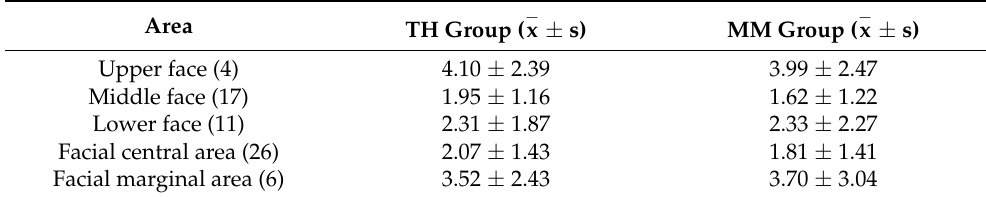
Table 3. Landmark localization error for the 3D facial anatomical landmarks based on facial area